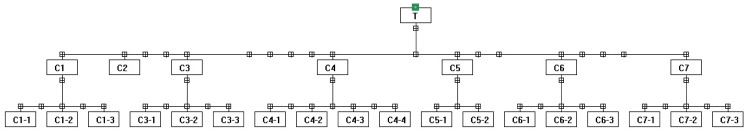
The criteria hierarchy.